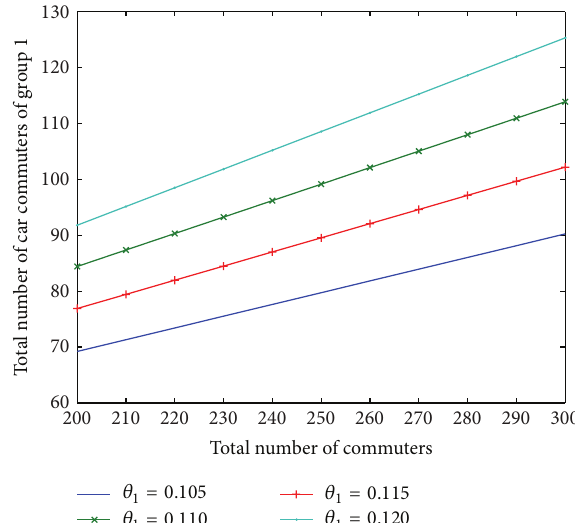
Figure 6: 𝑁 𝐴 versus 𝑁 with different 𝑇 𝑠 .